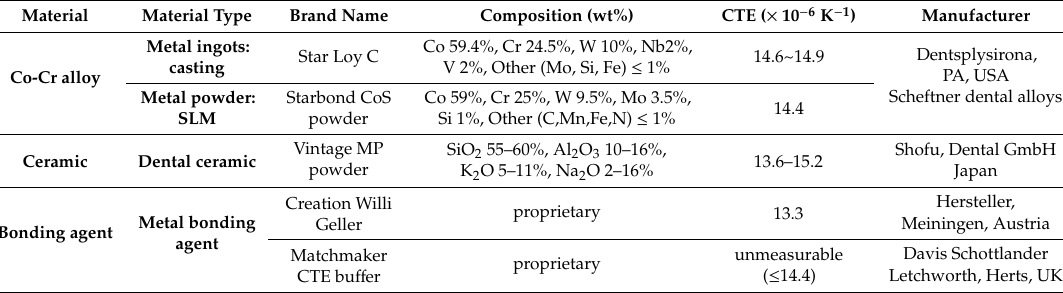
Figure 1. Flow chart of the bond strength experiments. Table 1. Specifications of the alloys, ceramic, and bonding agents used in this study.